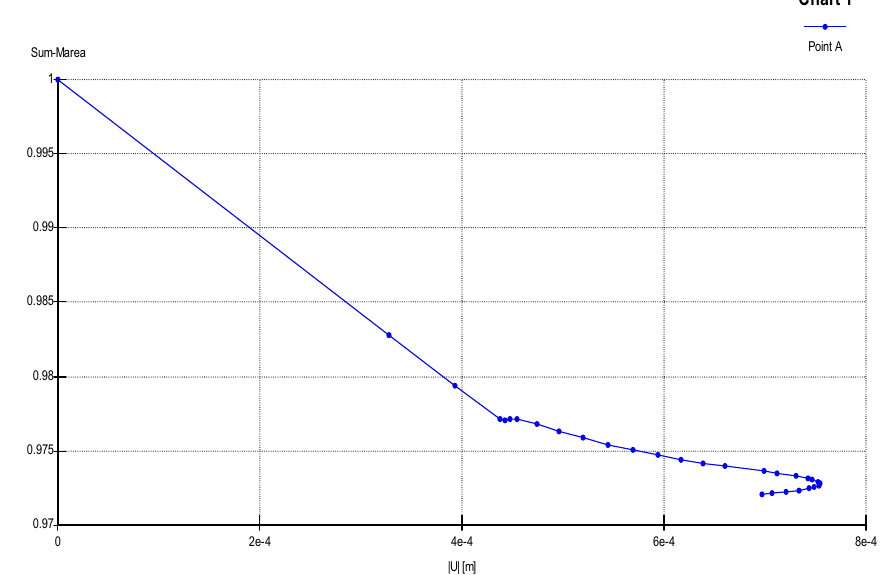
Fig. 10. Load- Displacement Curve for Hormheb tomb (KV57), the Sum-M area-U [m] Curve for point